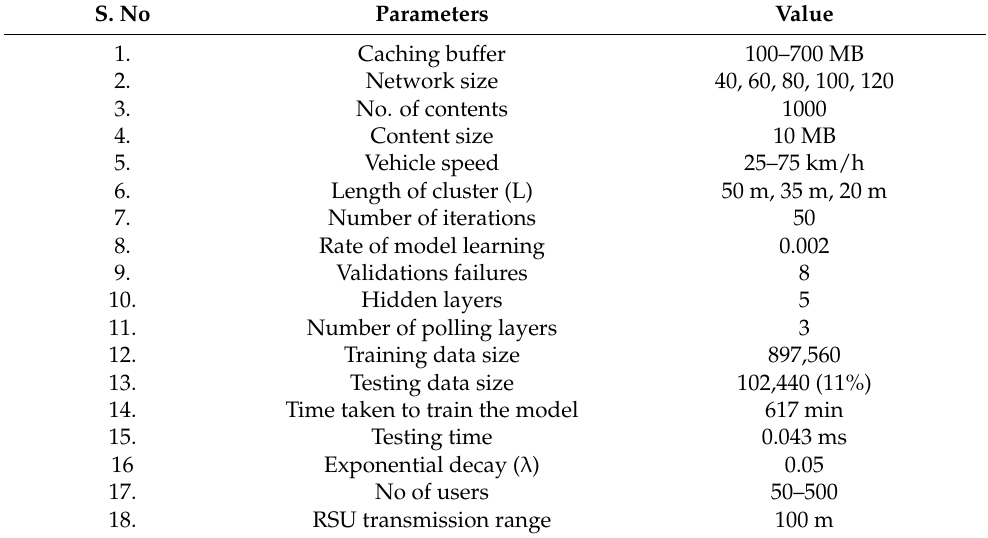
Table 4 details the simulation settings and implementation parameters. Table 4. Simulation settings and modeling